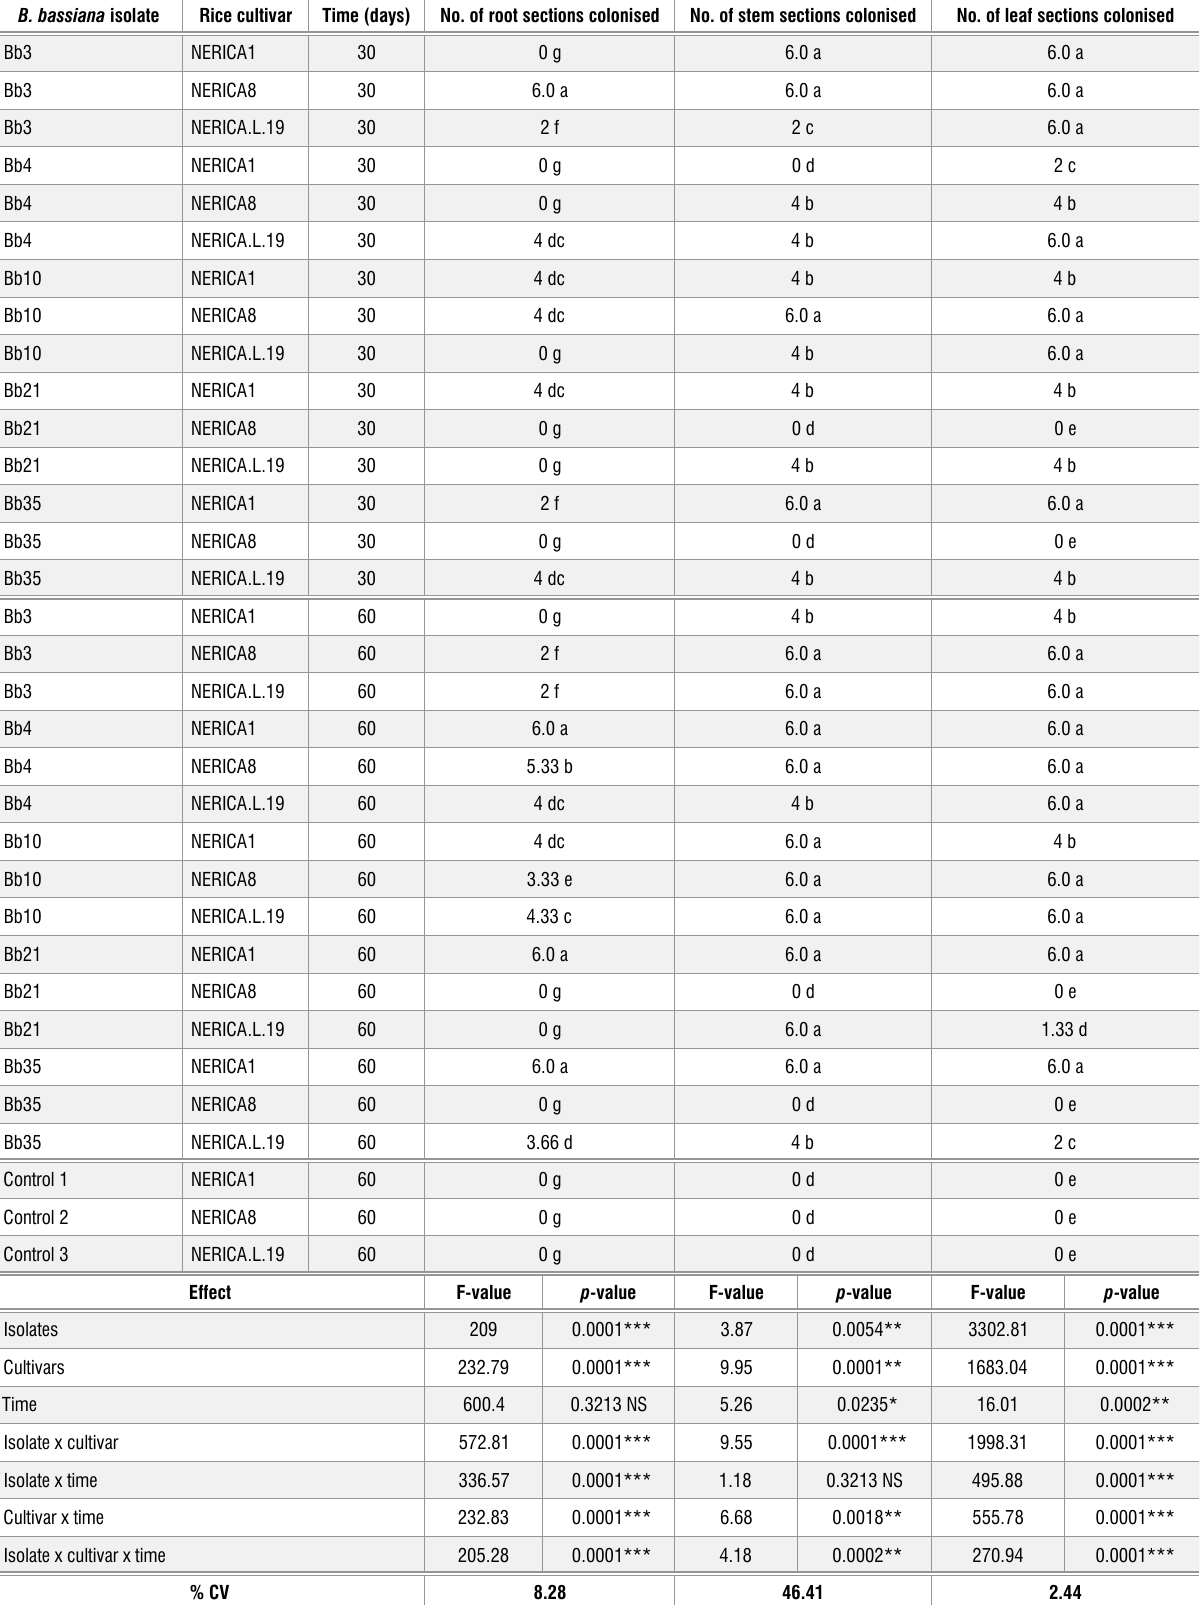
Table 2: Evaluation of endophytic behaviour of Beauveria bassiana strains in rice plants using foliar sprays inoculation B. bassiana